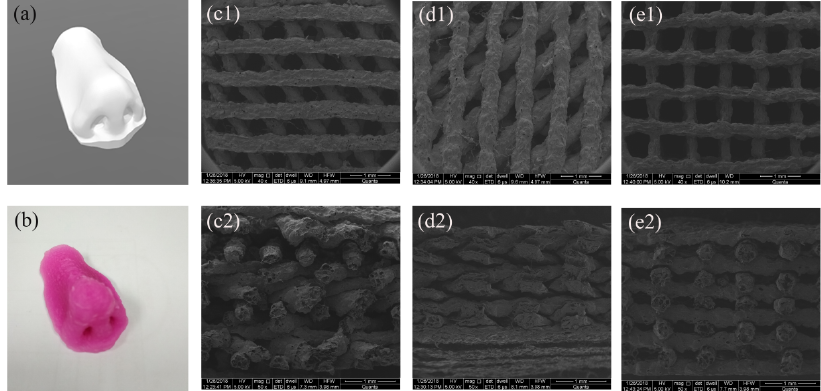
Figure 4. Morphological characterization of 3D printed hydrogels. Photographs of ( a ) 3D model of nose and ( b ) 3D printed nose prepared with 3D printing ink Al1Ch1.2. SEM micrographs of hydrogel with different angles between filaments, prepared with 3D printing ink Al1Ch1.0: ( c1 , c2 ) 45°; ( d1 , d2 ) 60°; ( e1 , e2 ) 90° (1 and 2 represent the front and side, respectively, of the scaffolds).